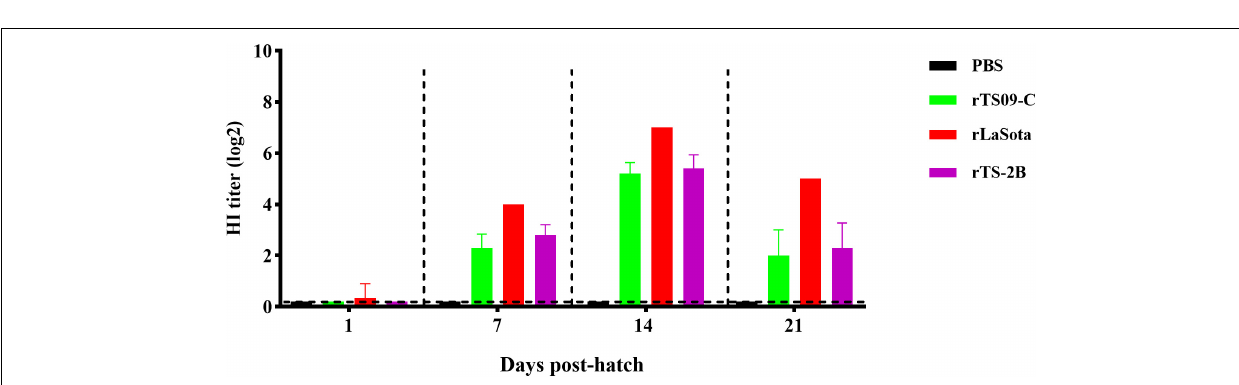
FIGURE 4 | NDV-specific hemagglutinin-inhibition antibody titers in immunized birds. Blood sample from five birds in each group were collected on the day of 1, 7, 14, and 21 dph. The antigen used for HI detection was from the LaSota strain.